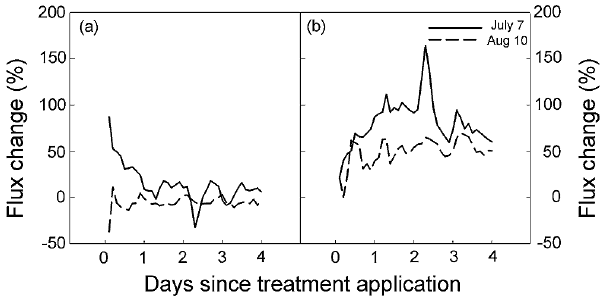
Fig. 3. Limitation of mineral soil respiration to (a) water and (b) sucrose over time for reference site experiments 1 (7 July) and 2 (10 August 2010).